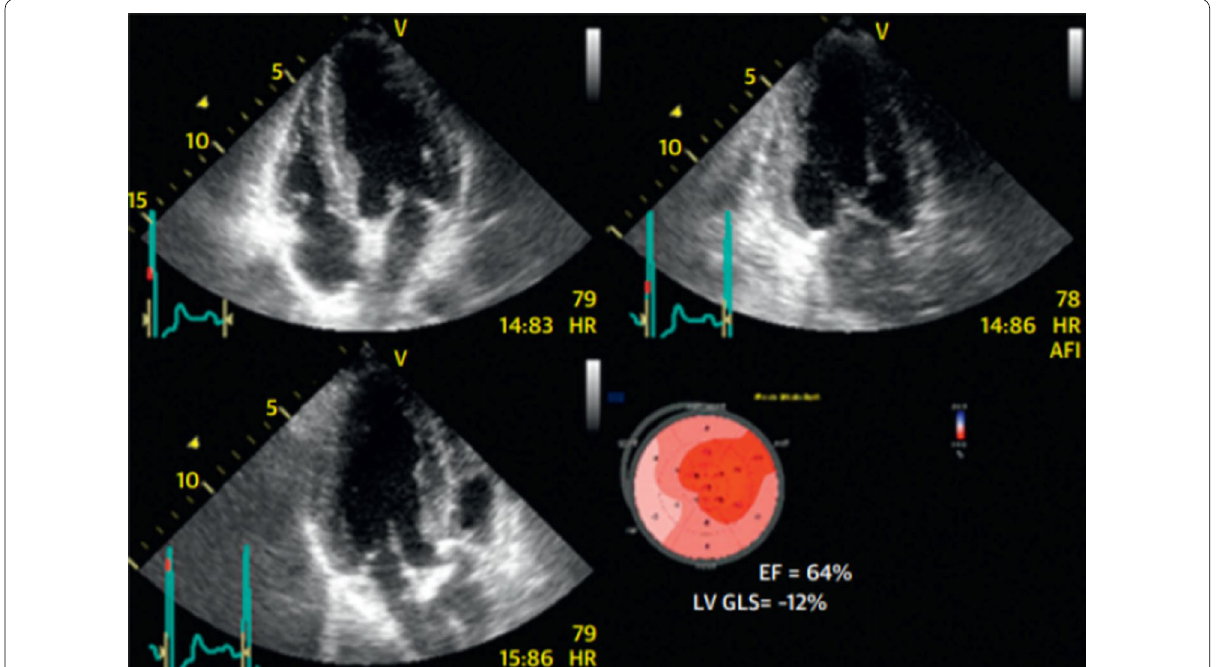
Fig. 2 Aortic stenosis patients with normal LVEF but impaired GLS show dysfunction of the left